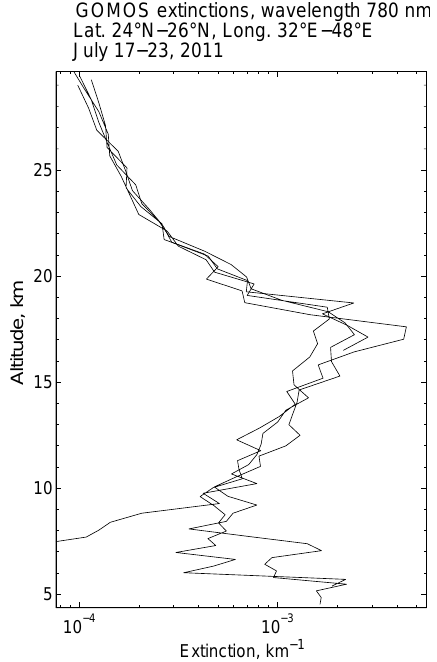
Fig. 13. Aerosol extinction profiles observed by GOMOS after the Nabro eruption. The profiles were retrieved in the frame of the AERGOM project.